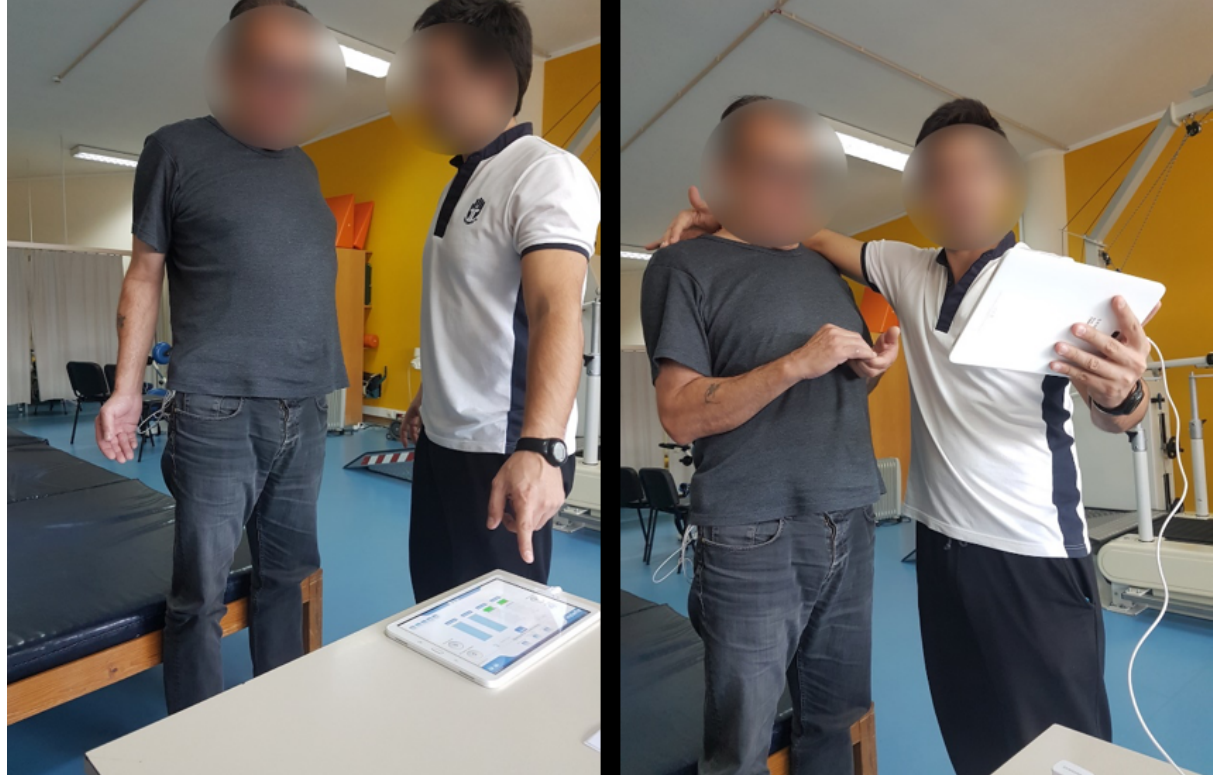
Figure 3. Physiotherapists often use their tablet application to explain to patients how to perform exercises correctly. Notice the calibration octopus in the pocket of the patient on both pictures, and the hand of the therapist correcting the exercise as the patient performs it, on the right